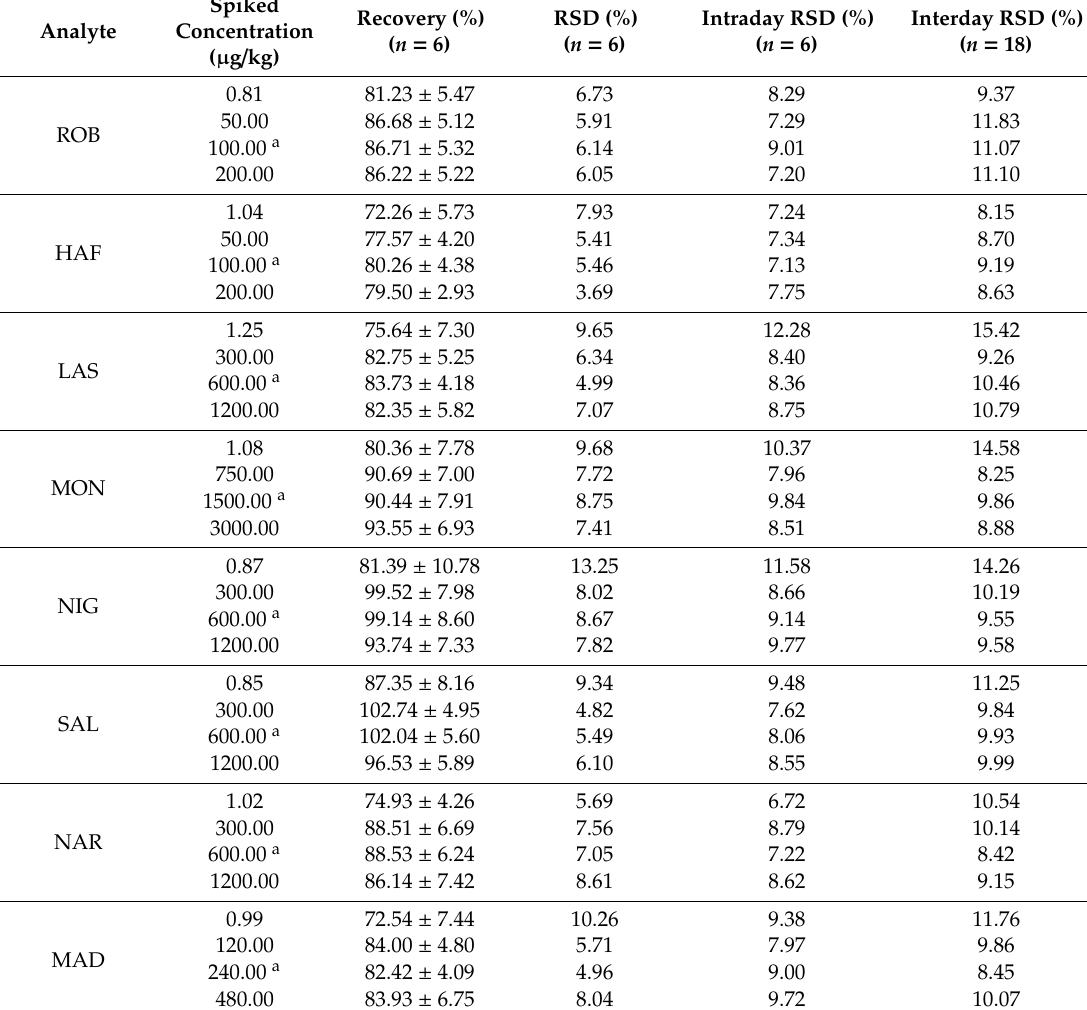
Table 4. Recoveries and precision of eight coccidiostats spiked in blank eggs in UPLC–MS / MS analysis. Spiked Recovery Analyte Concentration ( µ g / kg)